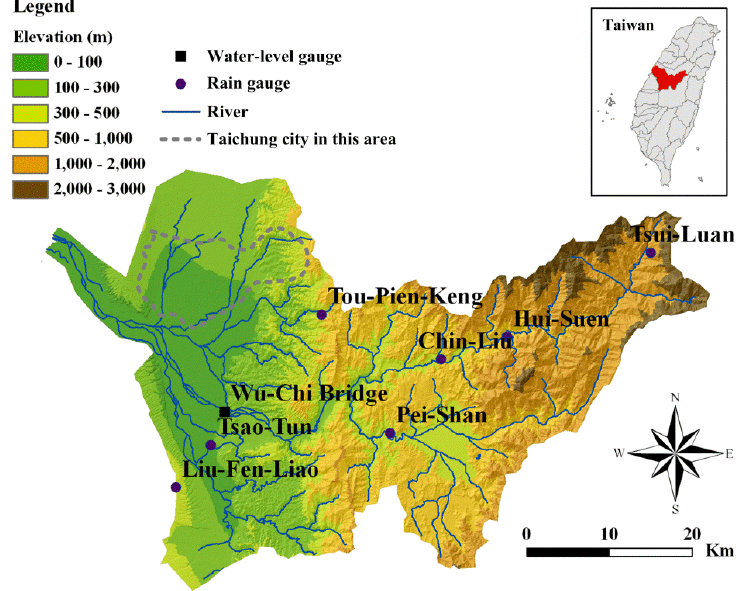
Figure 3. The study area and locations of rainfall and water level gauging